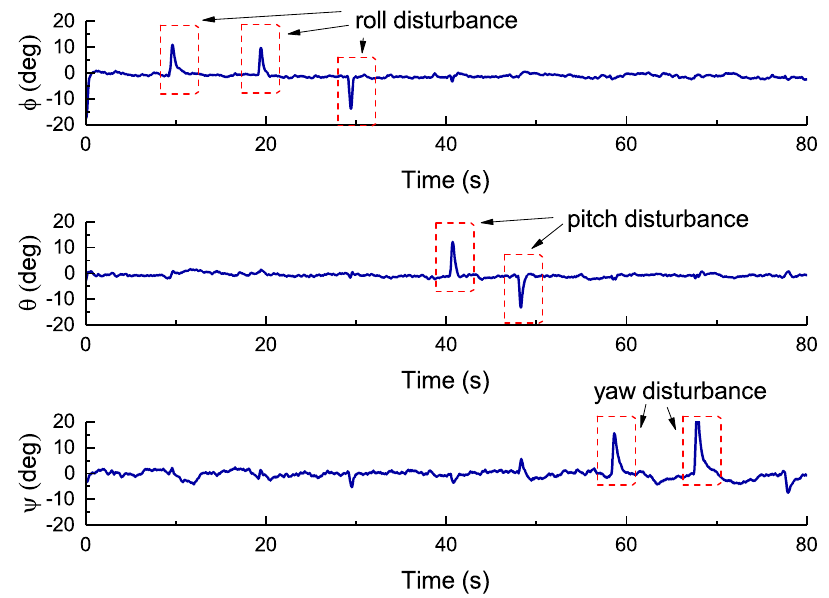
Figure 6. Attitude of NTAUV under PI control with disturbance on each axis.